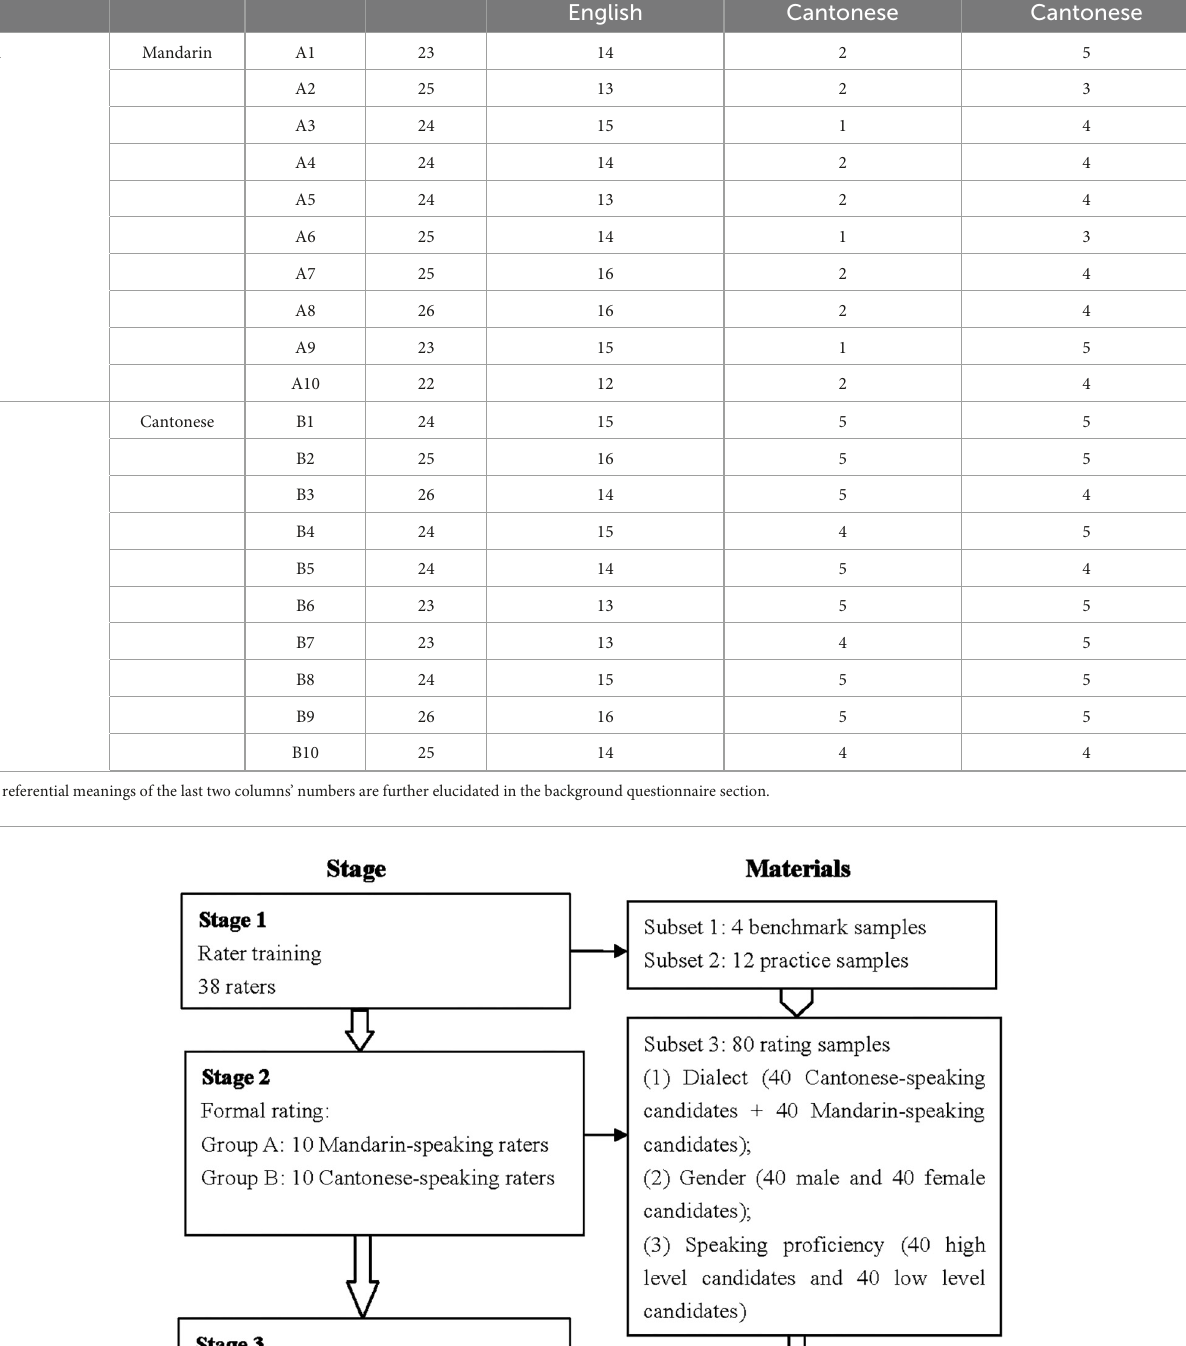
FIGURE1 The procedure.